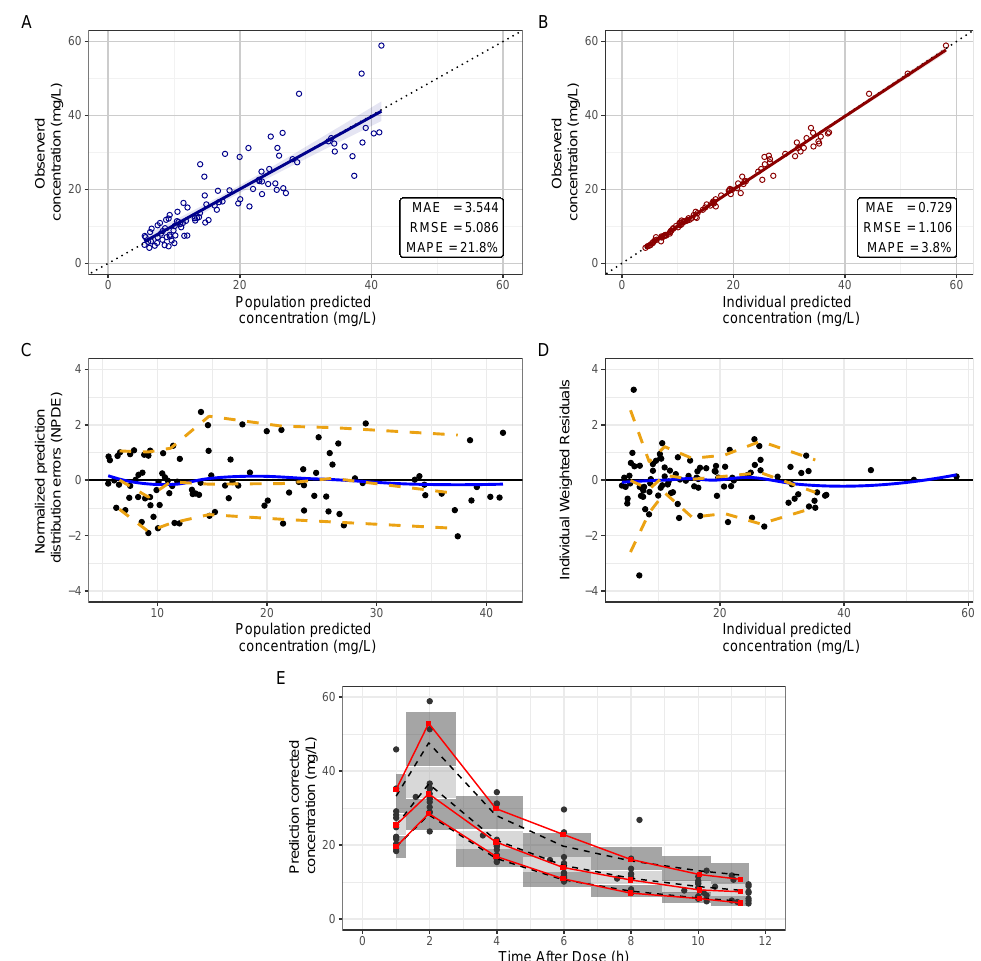
Figure 3. Goodness−of−Fit plots and visual predictive check for final VAN model. ( A ) Observation vs. population predictions plot for the final model. ( B ) Observation vs. individual predictions plot for the final model. ( C ) Normalized prediction distribution errors vs population prediction. ( D ) Individual Weighted Residuals vs Individual predicted concentration. ( E ) Prediction corrected visual predictive check (pcVPC) for each VAN concentration determination method, 2.5, 50, and 97.5% percentiles of observed data (solid red line) were shown, as well as simulated data (dark dash line). The confidence intervals for the percentiles of the simulated data are shown in the form of grey